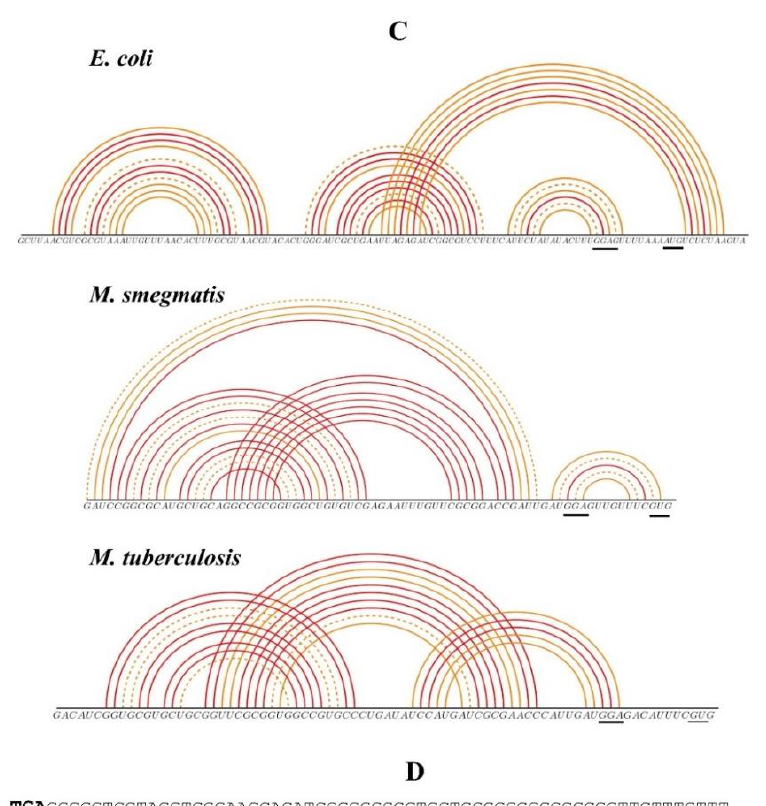
Figure 1. Regulatory elements in front of the rpsO coding region in E. coli , M. smegmatis, and M. tuberculosis. ( A , B ) Comparison of the core rpsO promoters ( A ) and 5 (cid:48) UTRs ( B ). The TSS (transcription start site), − 10, − 35 promoter regions ( A ) as well as the initiator codon and the Shine–Dalgarno element ( B ) are in bold. ( C ) 5 (cid:48) UTRs of E. coli , Msm, and Mtb rpsO mRNAs are able to form pseudoknots (according to [37]); the most stable structures are shown as pairing probability arcs. ( D ) Presumable intrinsic transcription terminator of the Msm rpsO gene; complementary sequences forming a hairpin structure are underlined.